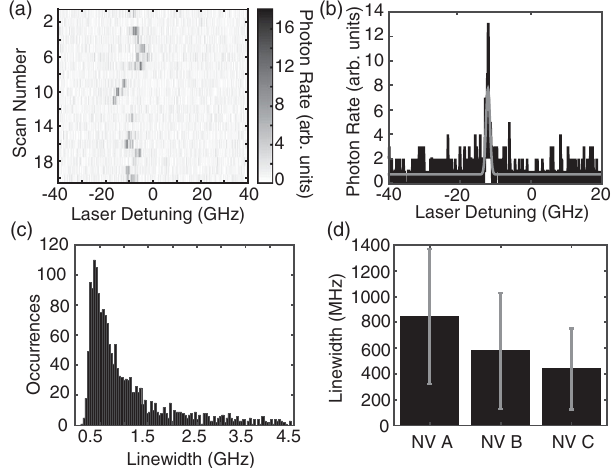
FIG. 4. (a) A typical multiscan measurement of a single, spectrometer-limited NV in a diamond μ WG with resonant excitation and collection of the phonon sideband at cryogenic temperatures (18 K). (b) A single scan with a Gaussian fit showing a linewidth of 918 MHz. (c) The distribution of measured single-scan linewidths of NV C, with a maximally occurring linewidth of 393 MHz. (d) Mean and standard deviation of measured single-scan linewidths for three NVs in individual μ